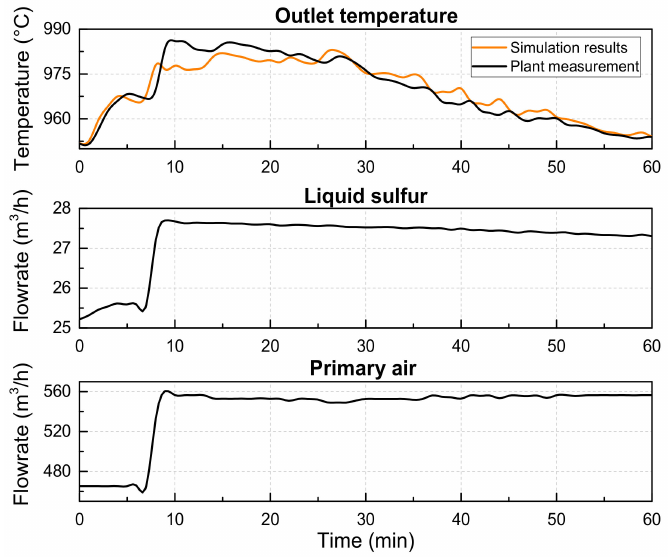
Figure 7. Comparison of the sulfur combustion furnace predicted and measured outlet temperature in response to inlet flow rate changes.